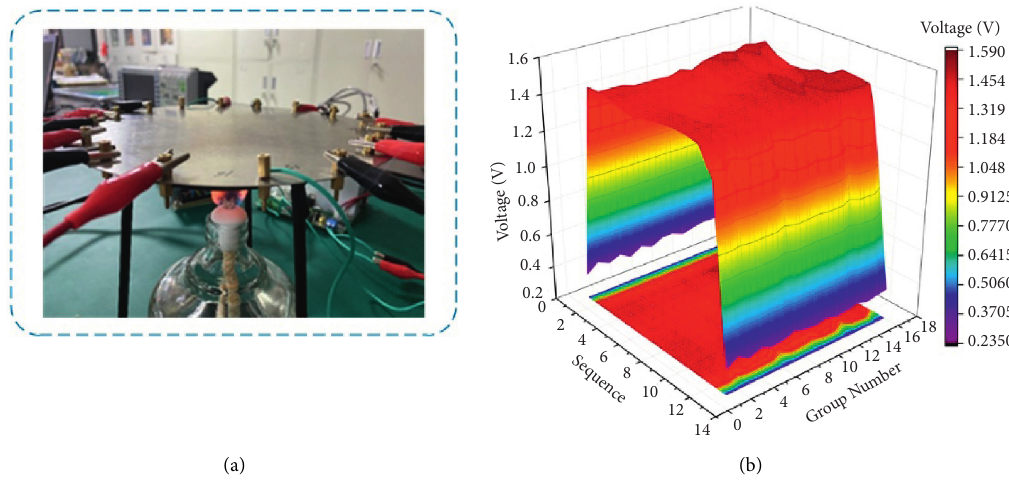
Figure 17: Experimental test diagram: (a) experimental platform; (b) heat-treated disc measurement data